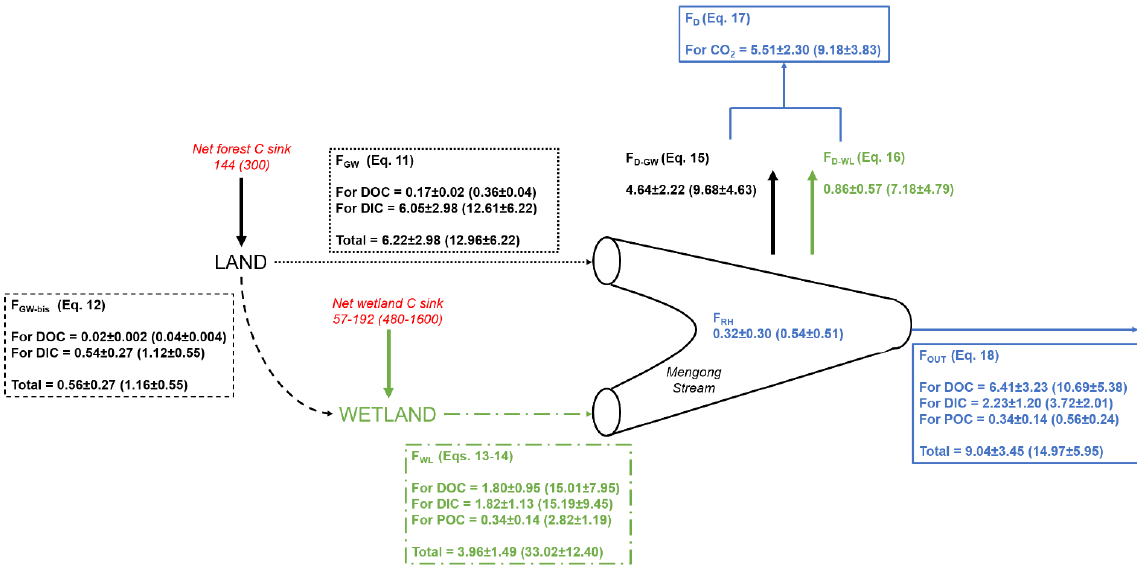
Figure 7. Mass balance of C in the first-order Mengong catchment. All fluxes are in MgCyr − 1 , and in MgCkm − 2 yr − 1 when between brackets (weighed by the surface area of 0.48km 2 drained by non-flooded forest groundwater for the net forest C sink, F GW , F GW-bis and F D-GW ; by the wetland surface area of 0.12 km 2 for the net wetland C sink, F WT and F D-W ; and by the Mengong catchment area of 0.6km 2 for F OUT , F D and F RH ) , and they are associated with their corresponding equations as described in detail in the Sect. 2.5. Briefly, F GW is the quantity of dissolved carbon leached from non-flooded forest groundwater to the Mengong stream (Eq. 11), F GW-bis is the quantity of dissolved carbon leached from non-flooded forest groundwater to the Mengong wetland (Eq. 12), F WL is the quantity of carbon leached from the Mengong wetland to the Mengong stream (Eqs. 13–14), F D is the quantity of C degassed from the Mengong stream to the atmosphere, F RH is the heterotrophic respiration in the Mengong stream and F OUT is the quantity of carbon hydrologically exported at the outlet of the Mengong stream. In addition, net forest C sink of the Mengong catchment estimated by Brunet et al. (2009) and a range of typical net wetland C sink measured in wetlands in Africa by Saunders et al. (2007) and Jones and Humphries (2002) are both indicated.